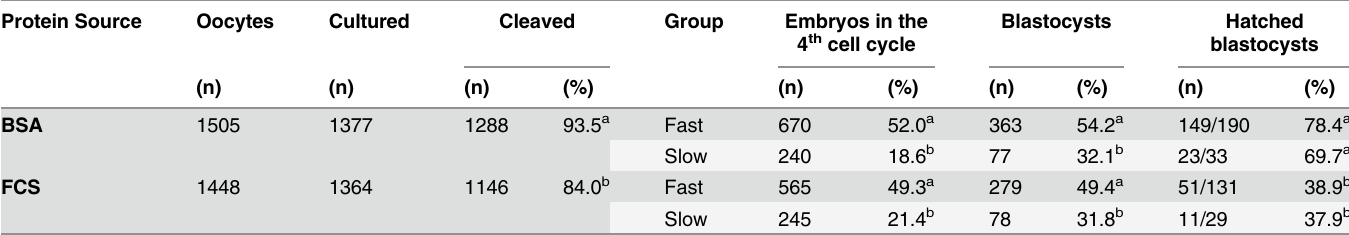
. The blastocyst rates were calculated based on the number of embryos that reached the 4th cell cycle.